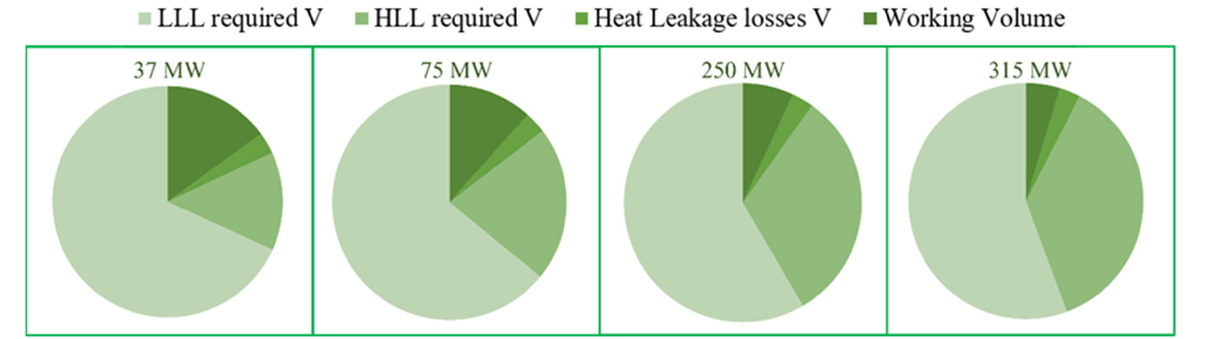
Figure 10. The portion of the total volume that is occupied by various mandatory terms . Calculations show that the volume for LAS needed to store the energy for the black- start solution, as indicated in the Huntorf plant, is 5482 cubic meters. Accordingly, pur- chasing the proper storage capacity, based on the availability on the market and advised dimensions with H/D = 0.8 [56], for a plant with 320 MW output power, 432 kg/s of mass fl owrate, and discharging time of 2 h, a 6000 m 3 tank with a diameter and height of 21.5 and 17 m is recommended.